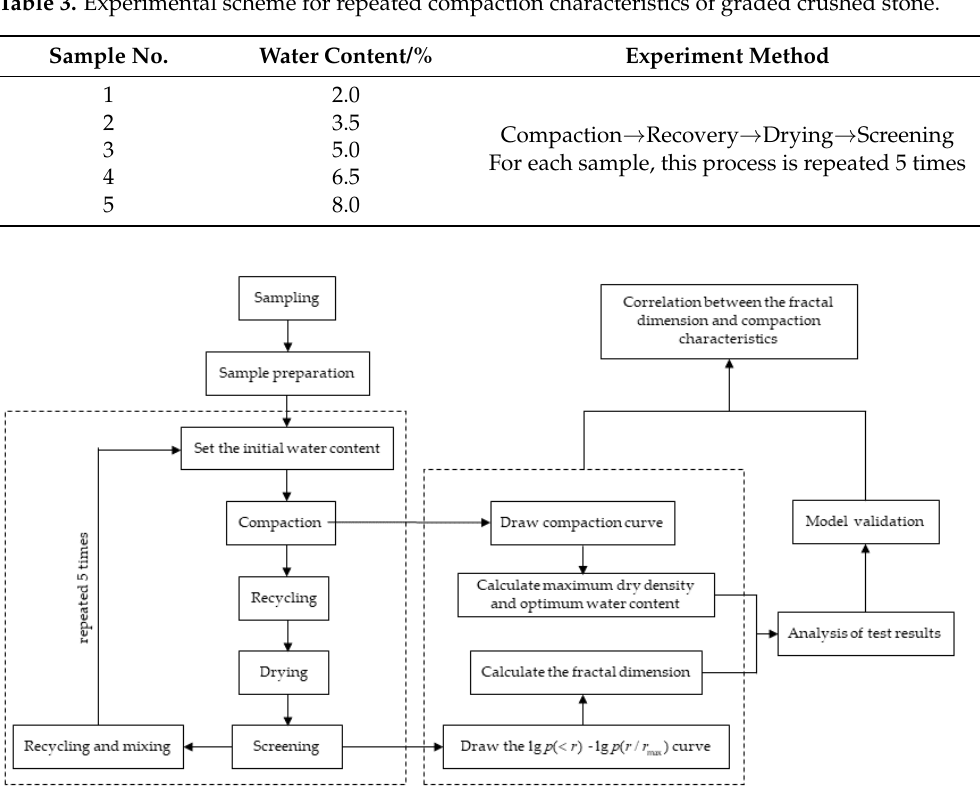
Figure 3. Workflow of repeated compaction test method.